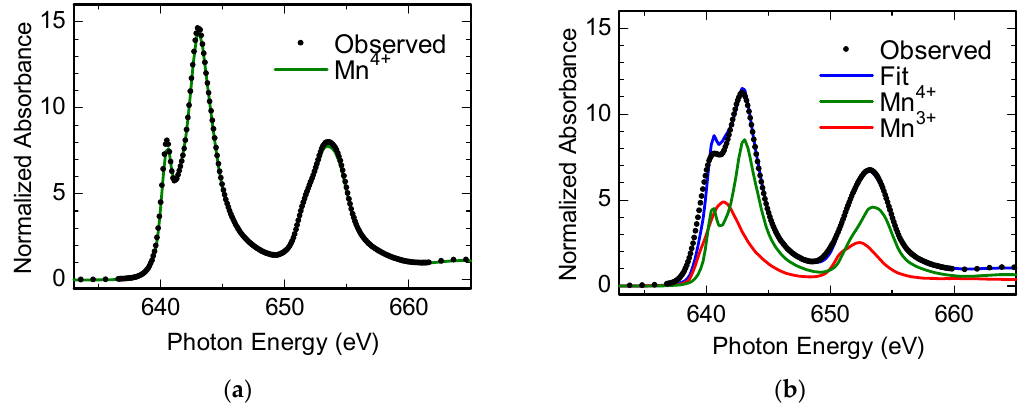
Figure 5. X-ray absorption near-edge structure (XANES) spectra measured in total electron yield mode at the Mn L 2,3 -edge of restacked ( a ) C23M77NS and ( b ) M100NS.